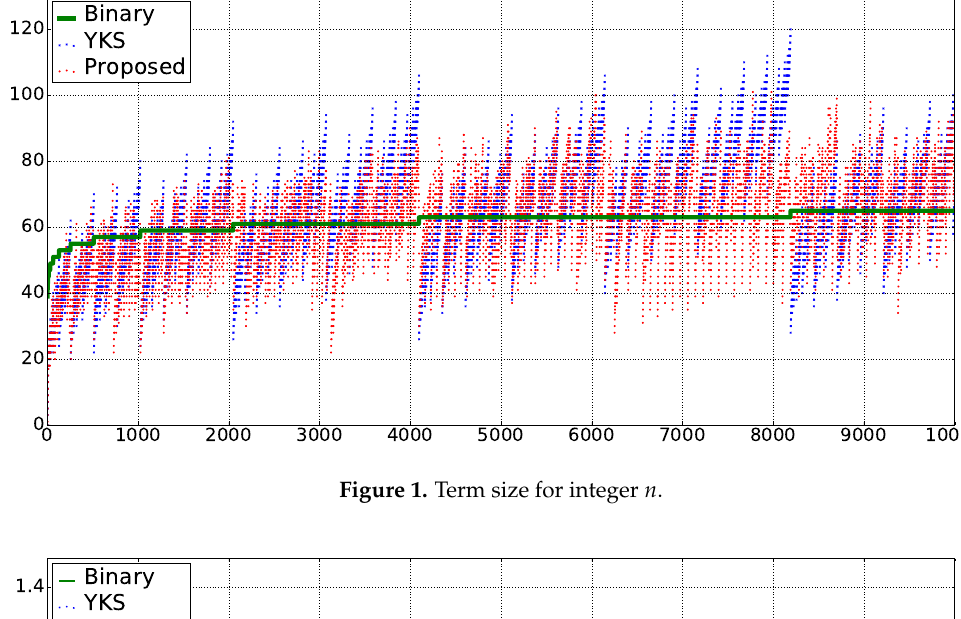
Figure 1. Term size for integer n .